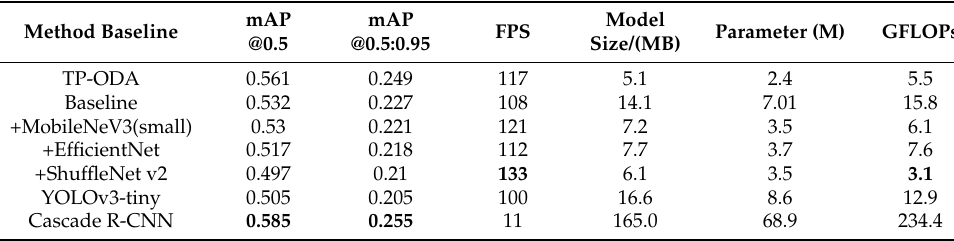
Table 6. The TP-ODA model was compared to the other models.